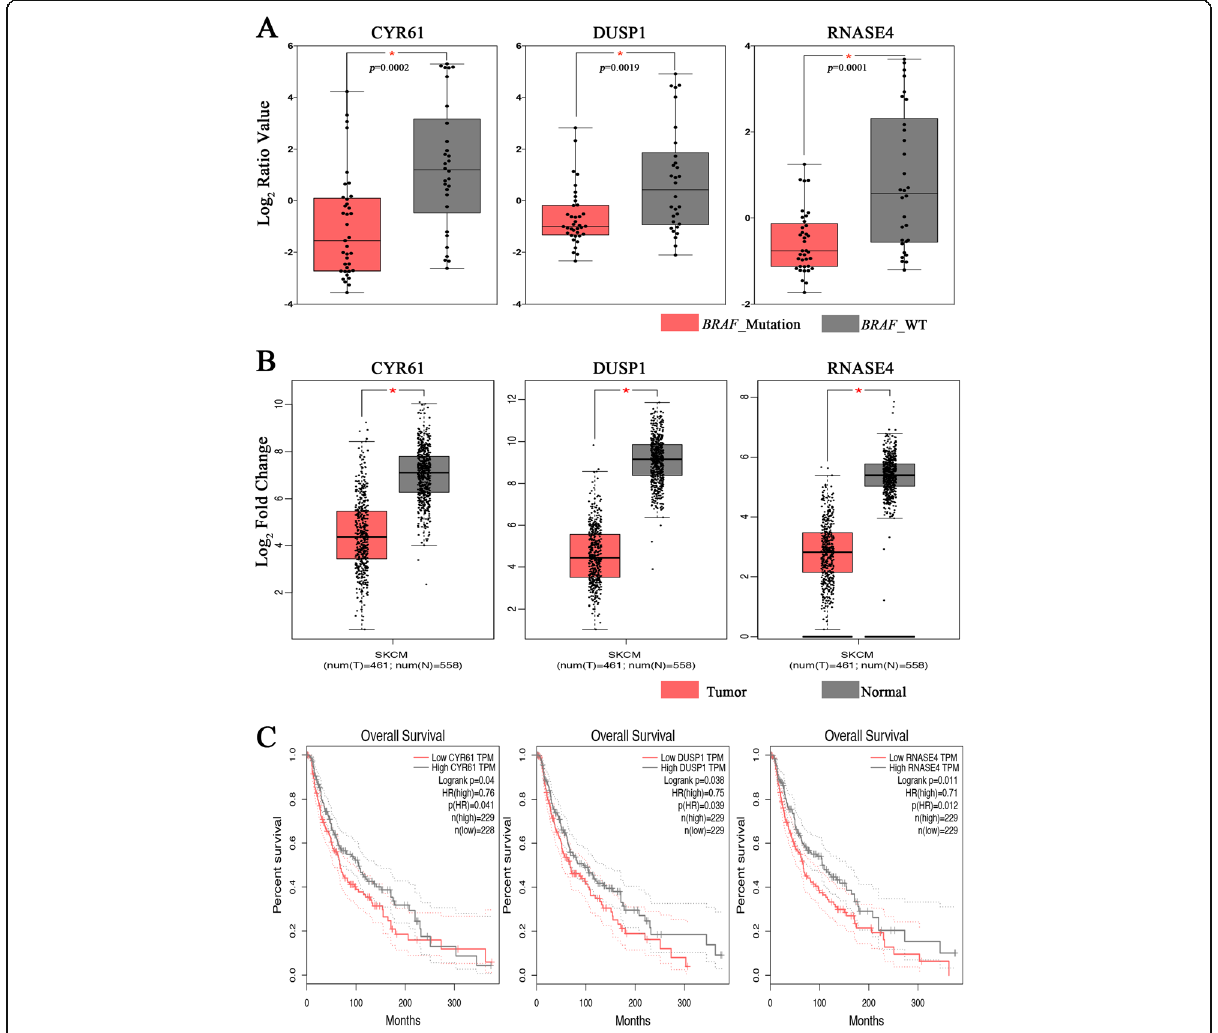
Fig. 6 a The gene expression (log2 ratio value) of CYR61 , DUSP1 , and RNASE4 in melanoma samples (unpaired t test, * indicates p < 0.01). b Validation of the gene expression of CYR61 , DUSP1 , and RNASE4 in TCGA-SKCM (including 461 tumor patients and 1 normal control) and GTEx (including 557 normal control). The cutoff was set to |log2 fold change (FC)| ≥ 1, and p < 0.01. * indicates p < 0.01. c Overall survival analysis of the expression level of CYR61 , DUSP1 , and RNASE4 in TCGA-SKCM on GEPIA